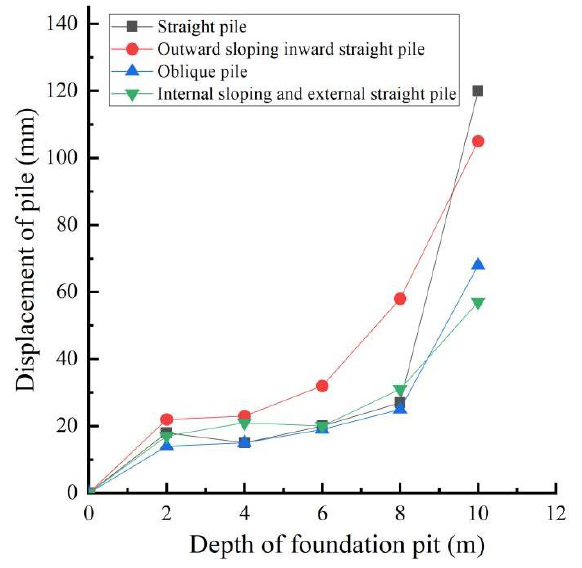
Figure 1. Variation of displacement of row pile under different working conditions.